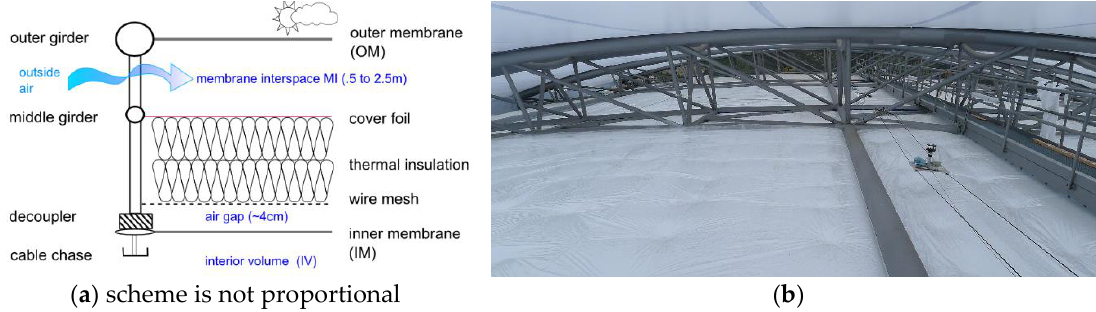
Figure 3. ( a ) Side view scheme of the roof layer construction; and ( b ) photograph of the membrane interspace. A monitoring platform for other measurements is visible on the two ropes on the right-hand side of the image. Table 2. Material properties of the building’s non-opaque components.